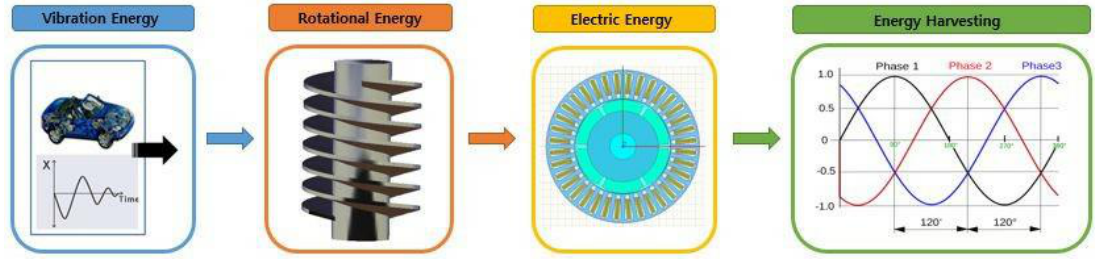
Figure 4. Schematic diagram.